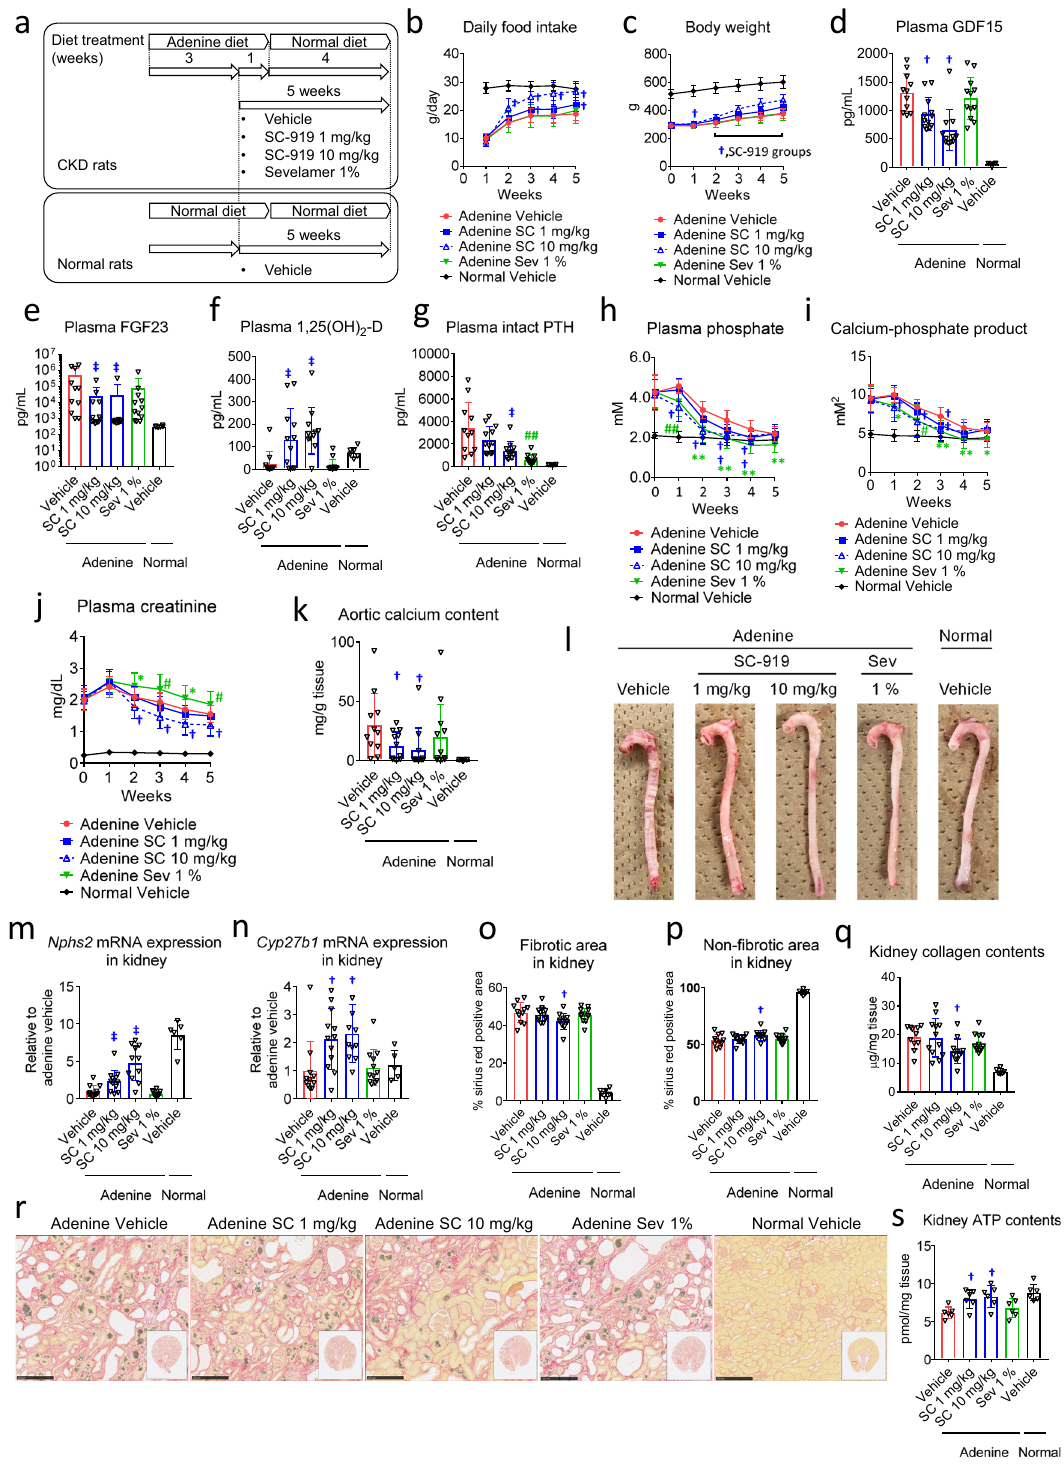
Fig. 6 Chronic IP6K inhibition alleviates CKD-induced hyperphosphataemia and related parameters in adenine-treated rats. Evaluation of the chronic effect of SC-919 in adenine-treated rats. a Experimental protocol for a – r . b Daily food intake. c Body weight. d Plasma GDF15 levels. e Plasma FGF23 levels. f Plasma 1,25(OH) 2 -D levels. g Plasma intact PTH levels. h Plasma phosphate levels. i Plasma calcium-phosphate products. j Plasma creatinine levels. k Aortic calcium content. l Representative aortic images. Levels of the m Nphs2 and n Cyp27b1 mRNAs in the kidney. o Fibrotic and p non- fi brotic area in kidney. q Kidney collagen contents. r Representative kidney images (bar = 250 μ m, each lower right square shows the entire kidney image). Animals found dead during the study (1 rat in vehicle, 1 rat in SC-919 10 mg/kg). ( n = 11 – 12 biological replicates for adenine-treated rats and n = 5 – 6 biological replicates for normal rats for a – r ). s Kidney ATP levels (6 h after the drug dose) in adenine-rats treated with SC-919 for 8 days. ( n = 6 biological replicates). Values indicate mean ± S.D. † P < 0.05 and ‡ P < 0.05 vs. vehicle as determined using Williams ’ test and Shirley – Williams test, respectively. * P < 0.05 and ** P < 0.01 vs. vehicle as determined using Student ’ s t -test and # P < 0.05 and ## P < 0.01 vs. vehicle as determined using the Aspin – Welch test. Sev,